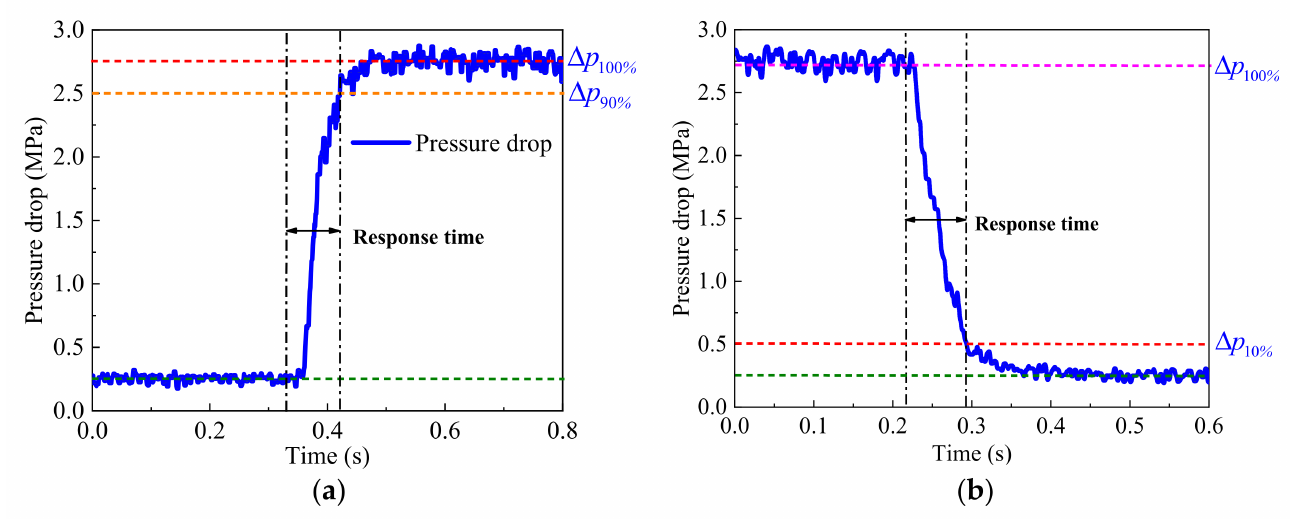
Figure 12. Definition of response time of the MR valve: ( a ) rising response time, ( b ) falling response